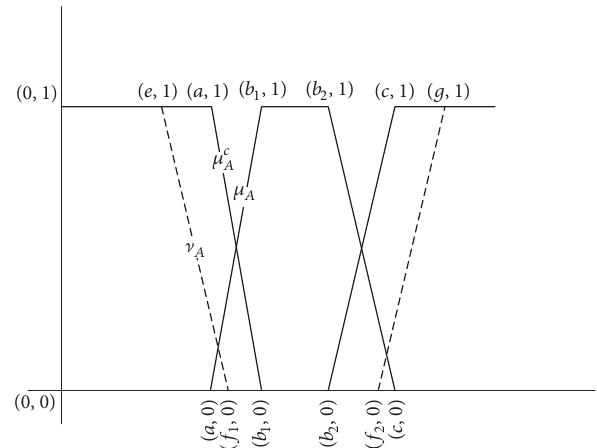
Figure 2: Trapezoidal intuitionistic fuzzy number.